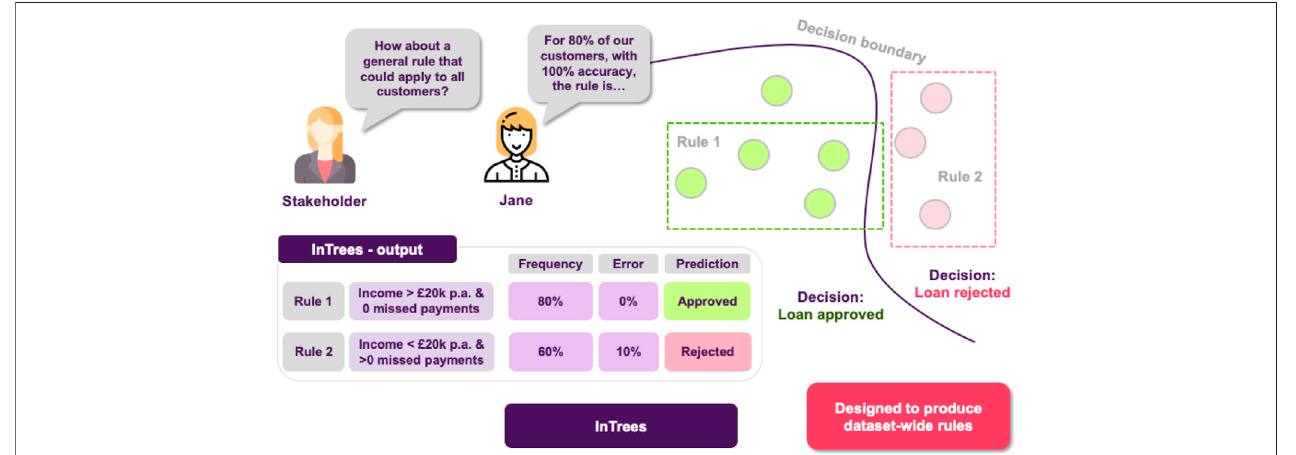
FIGURE 11 | Extracting rules from a random forest. Frequency of a rule is de fi ned as the proportion of data instances satisfying the rule condition. The frequency measures thepopularity oftherule. Errorofa rule isde fi ned asthe number ofincorrectly classi fi edinstancesdetermined bythe rule. So sheisable tosay thatfor 80%of the customers with 100% accuracy (ie. 0% error), when income > 20 k and there are zero missed payments, the application is approved.